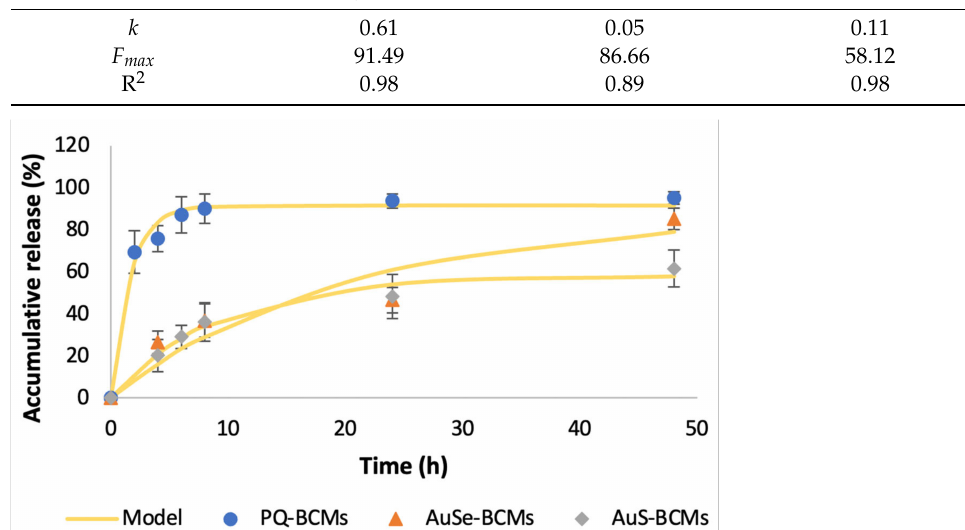
Figure 6. In vitro PQ, AuSe, and AuS release profile from PQ-BCMS, AuSe-BCMs, and AuS-BCMs, respectively, at pH 7.4 and mathematical modeling of the in vitro release profile from the micelles, using a first-order